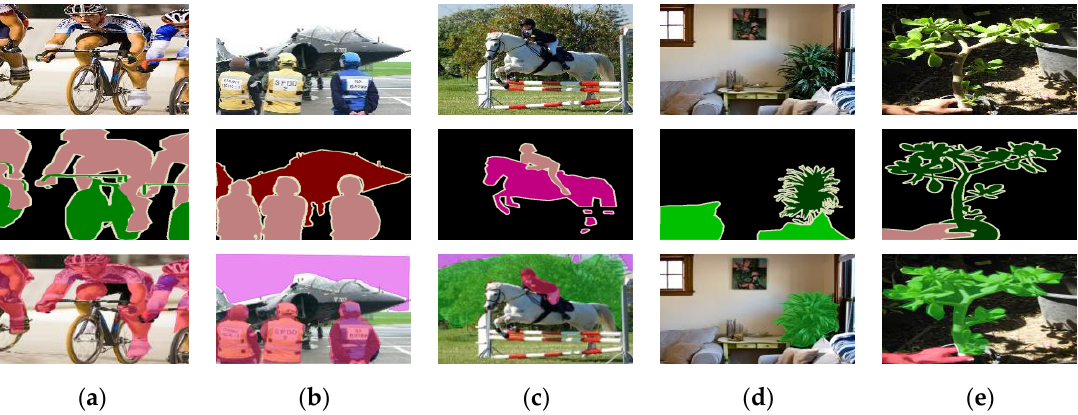
Figure 12. Segmentation results of different scenes on PASCAL VOC 2012: ( a ) people scene; ( b ) sky and people scene; ( c ) sky, people, and tree scene; ( d ) tree scene; ( e ) tree and people scene.